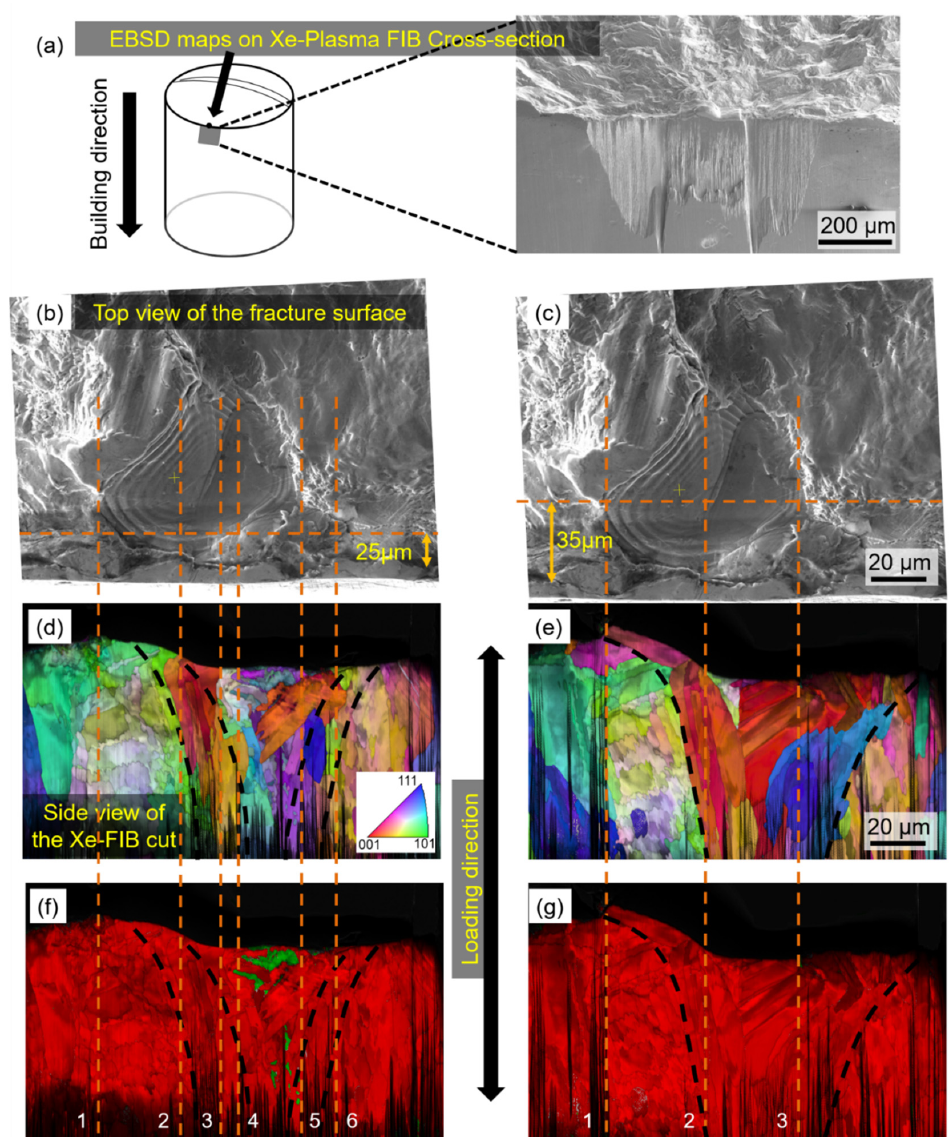
Figure 3. ( a ) Schematic of the PFIB cross section with an SEM image of the region prepared for EBSD. ( b , c ) Top view SEM images of the fracture surface including the LOF defect. The orange horizontal lines show the position of the cross section. ( d , e ) Inverse pole figure (color) combined with image quality (grey level) maps showing the grain structure. ( f , g ) Phase maps (color) combined with image quality (grey level) maps showing austenite (red) and α ’-martensite (green) in the vicinity of the crack initiation site. Note that ( d – g ) show cross-sectional views with the crack surface perpendicular at the upper edge of the image. The lines 1 to 6 indicate the location of the microstructure in the cross-sectional views in relation to the fracture surface.